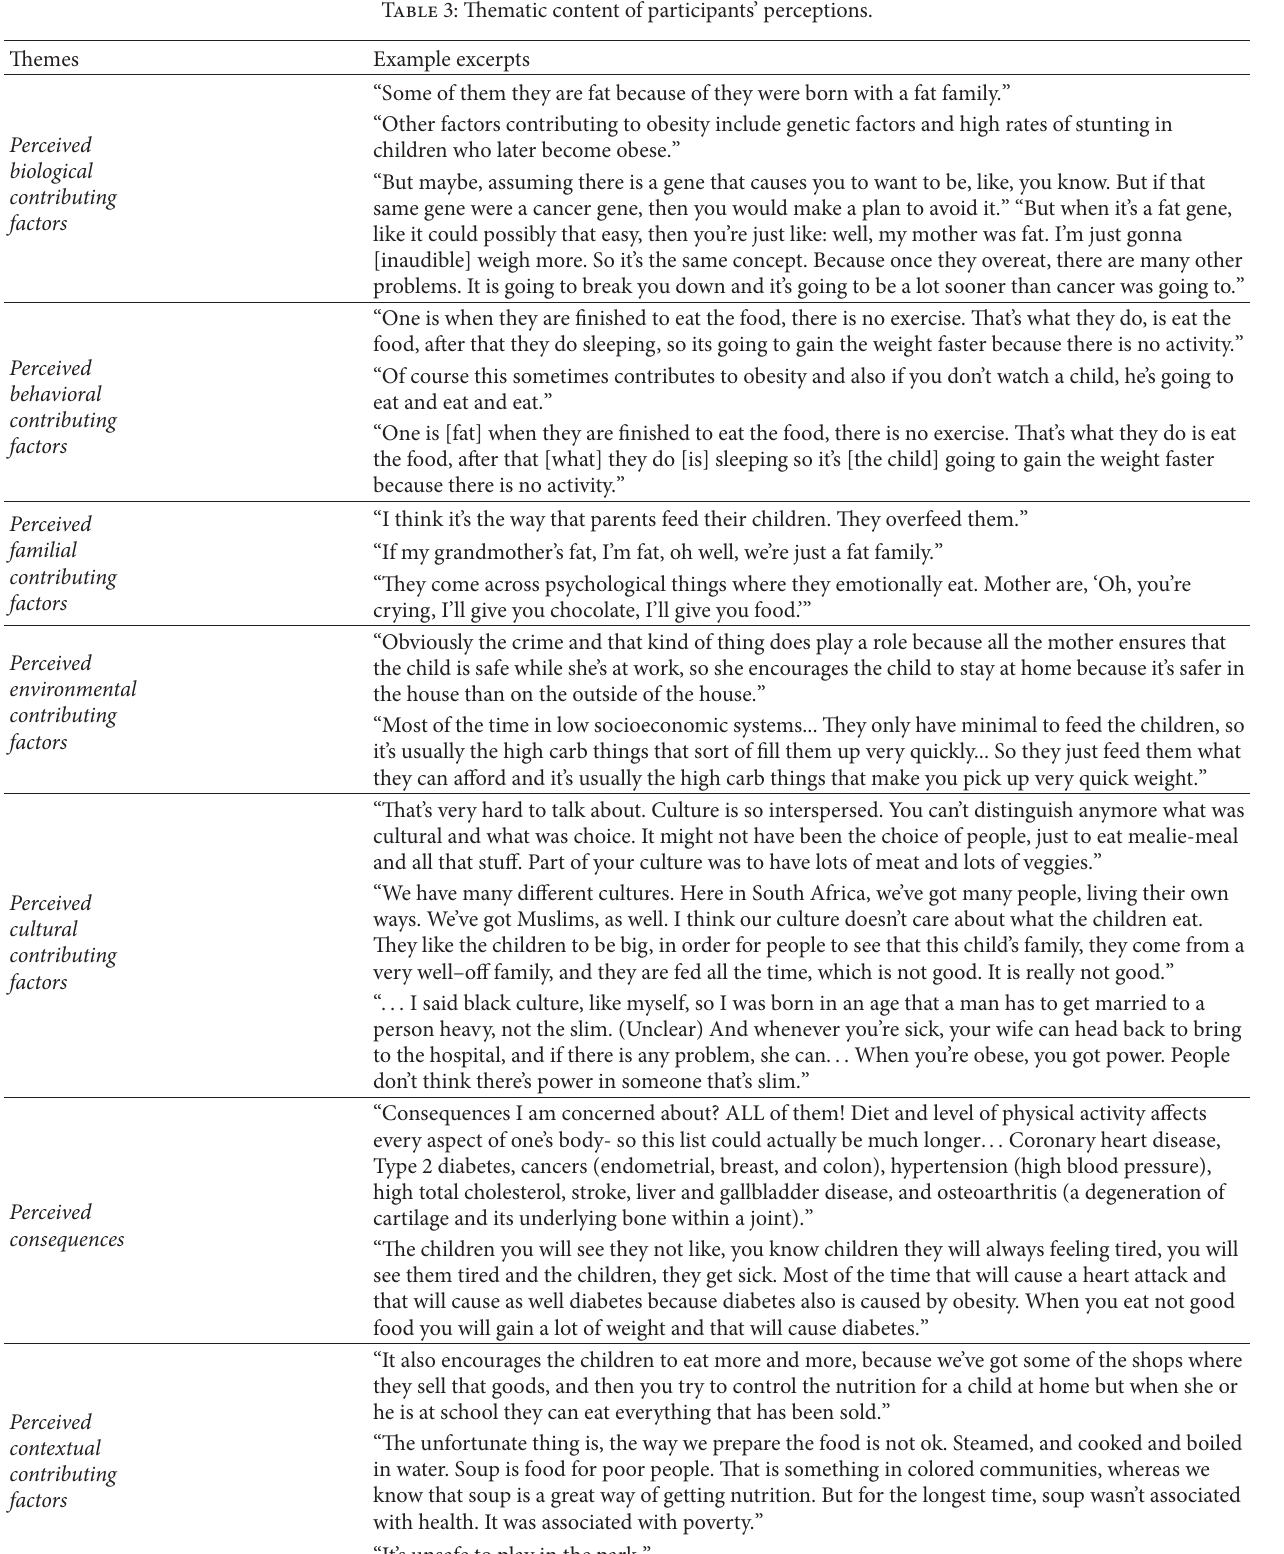
Table 3: Thematic content of participants’